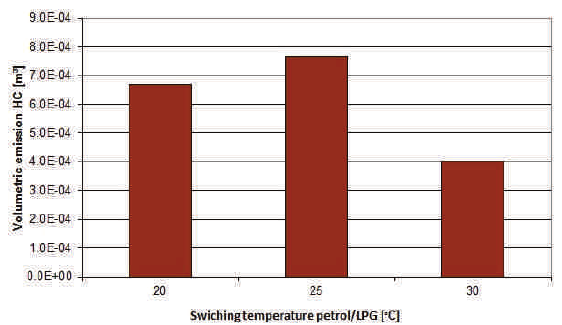
Fig. 9. Cumulative HC emissions in the fume gases from cold start to fuel switching moment The test assumption was to set fuel switching temperatures that did not cause engine malfunction during the test run. The standard temperature has been set (temperature which is often chosen by installers) and two other one by five degrees higher and one five degrees lower than standard temperature. Based on the graphs, it can be stated that the reducer temperature settings for fuel switching in the range of 20-25 o C do not